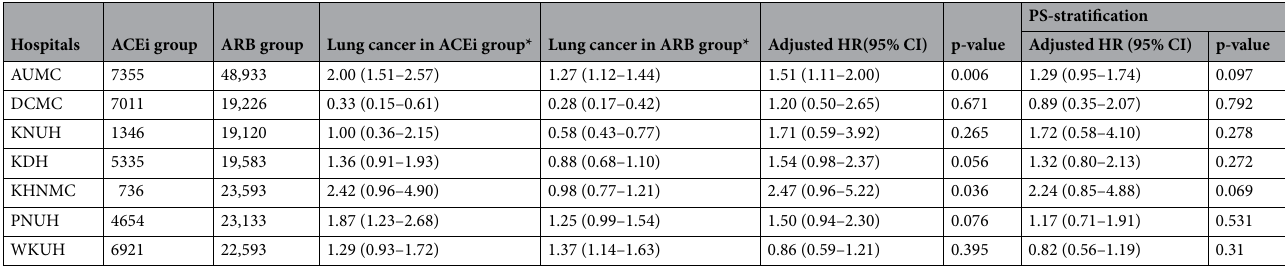
Table 2. Incidence of lung cancer in the whole cohort. *Incidence rate are presented as per 1000 years (95% confidential interval). ACEi Angiotension converting enzyme inhibitor, ARB Angiotension receptor blocker,